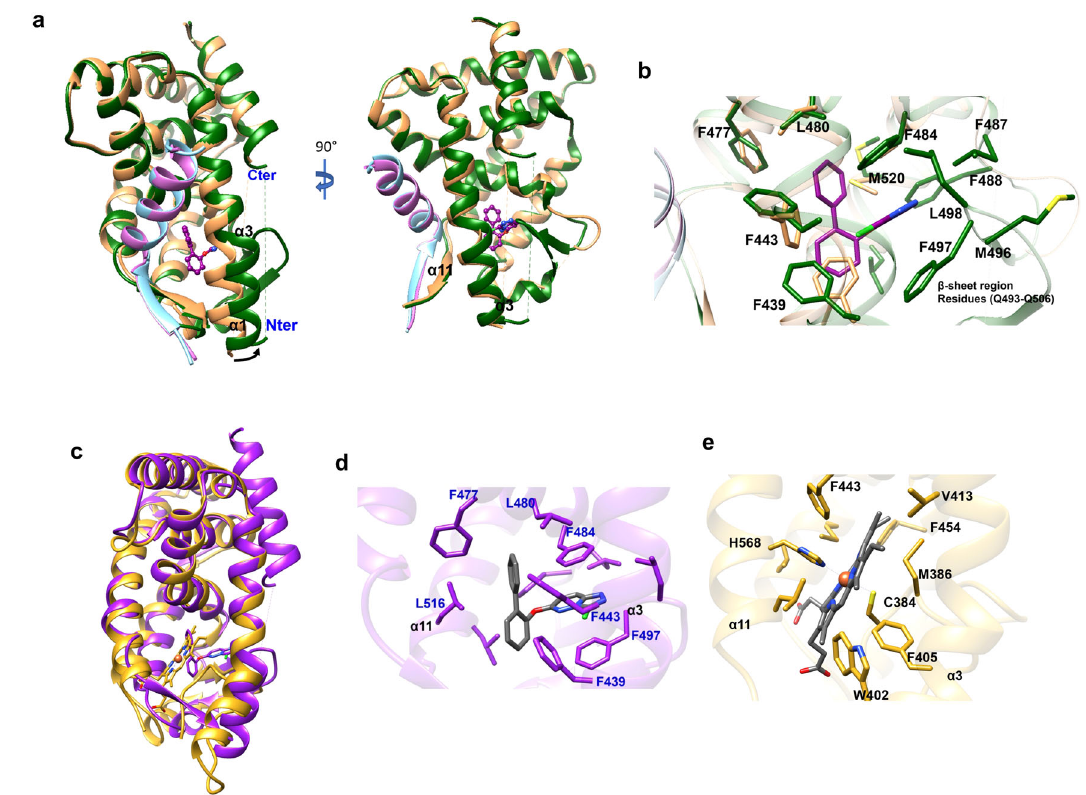
Fig. 4 | Schematic illustrating effects of STL1267 binding and comparison to apoREV-ERB α andhemeboundREV-ERB β .a OverlayoftheREV-ERB α /NCoRID1/ STL1267 (protein is shown as green ribbons, NCoR peptide as blue ribbons and ligand carbons are shown in purple) and REV-ERB α /NCoR ID1 (protein is shown as orange ribbons, NCoR peptide as pink ribbons, PDB:3N00). b Detailed view of the superimposed ligand binding pockets of both structures. Orange amino acid